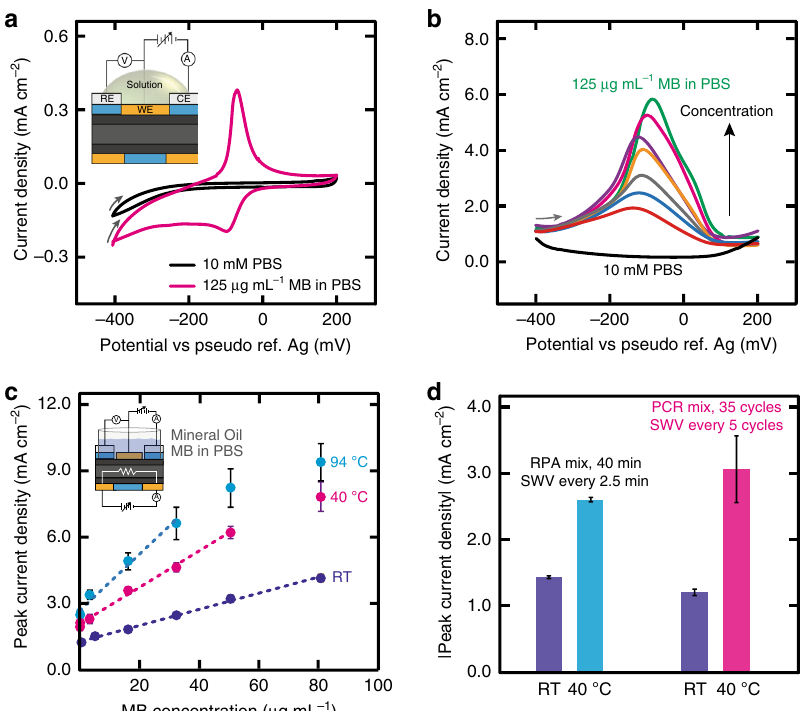
Fig. 4 Characterization of electrochemical sensing. a CVs recorded in 0 and 125 µ g mL − 1 aqueous solutions of MB in PBS. Scan rate = 100 mV s − 1 . b SWVs recorded in MB solutions in PBS at room temperature in a range of concentrations from 0 to 125 µ g mL − 1 . c Calibration curves of peak current densities vs concentration from SWVs recorded in MB solutions in PBS in a range of concentrations from 0 to 80 µ g mL − 1 at different temperatures. Error bars correspond to standard deviations from results using 5 devices ( N = 5). d Histogram showing average values from SWVs recorded in RPA mastermix and PCR mastermix at room temperature and under NA ampli fi cation conditions. Error bars correspond to standard deviations from peak current intensities measured from 17 (RPA) and 8 (PCR) SWVs. In all experiments shown in this fi gure, each repeat is performed with a new TriSilix